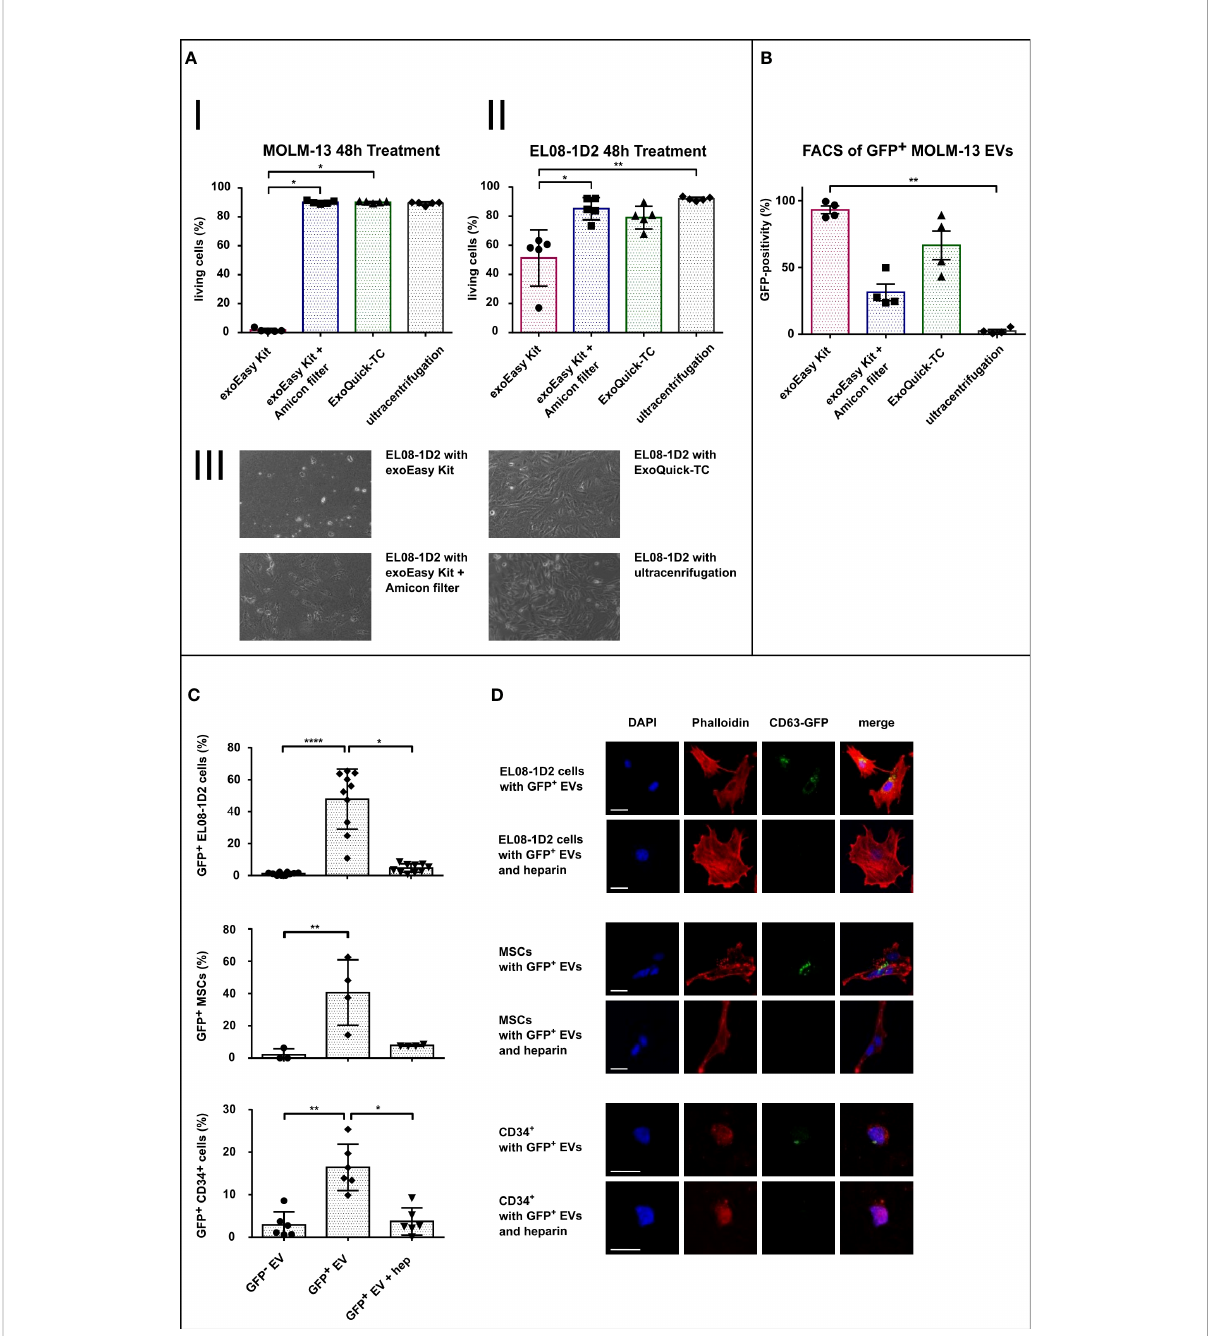
FIGURE 5 Assessment of EV isolation procedure compatibility with functional assays. (A) Histograms representing FACS viability assays of MOLM-13 (I) and EL08-1D2 cells (II) after treatment with different EV isolation buffers for 48 h (n = 5), and representative images of EL08-1D2 cells after 48 h treatment with the different isolation buffers (III). (B) FACS analysis of latex beads loaded with CD63-eGFP expressing MOLM-13-derived EVs following different isolation methods (n = 4). (C, D) Internalization assay of MOLM-13-derived EV (GFP - EV) or CD63-eGFP expressing MOLM- 13-derived EV (GFP + EV) into target cells (EL08-1D2, n = 10 independent experiments; MSC, n = 4 different donors; HSPCs, n = 6 different donors) with or without additional heparin (hep) treatment. Quanti fi cation of GFP-positive cells (C) and corresponding confocal microscopy images (scale bar set to 20 µm) (D) . * p <0.05, ** p <0.01, **** p